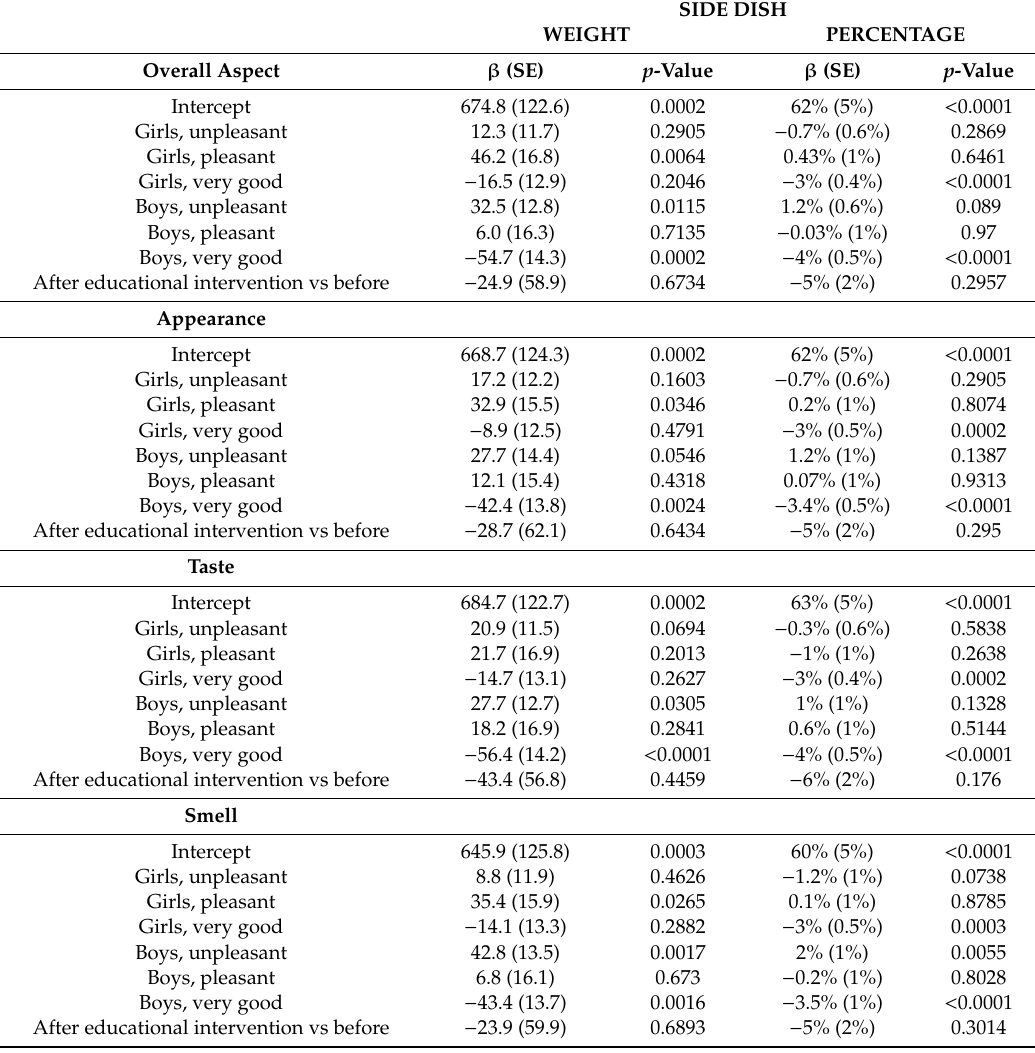
Table 7. Regression coe ffi cients of the model evaluating waste weight and percentage for the side courses for the numbers of boys and girls expressing pleasant, indi ff erent or unpleasant judgments on overall aspect, appearance, smell and